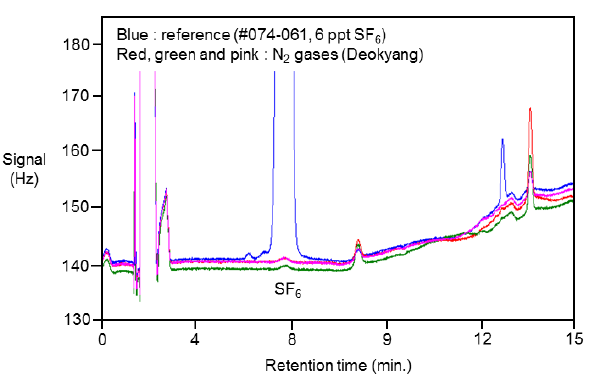
Fig. 7. Chromatograms of trace SF 6 in pure nitrogen (red, green, Figure 7 Chromatograms of trace SF 6 in pure nitrogen (red, green, and pink) and KRISS SF 6 2 and pink) and KRISS SF 6 standard (blue, 6ppt in standard (blue, 6 ppt in nitrogen) 3